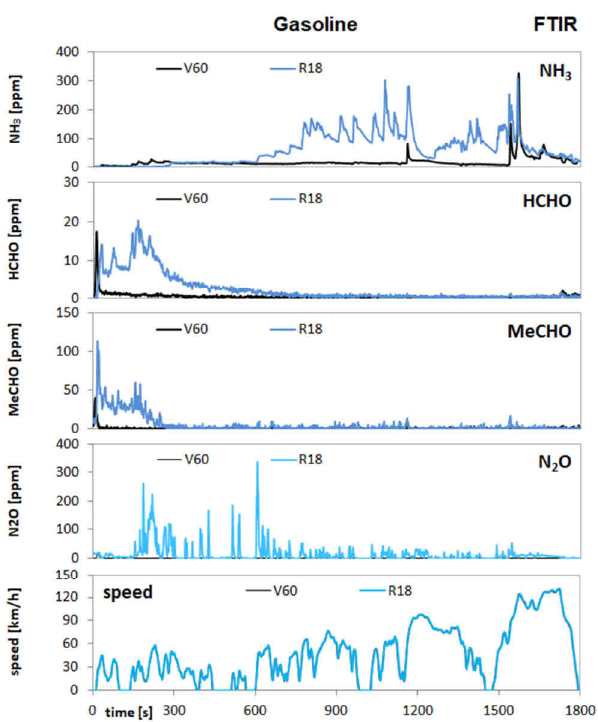
Fig. 7. Comparison of NH3-, HCHO-, MeCHO and N2O-emissions of two vehicles during the driving cycle WLTC cold